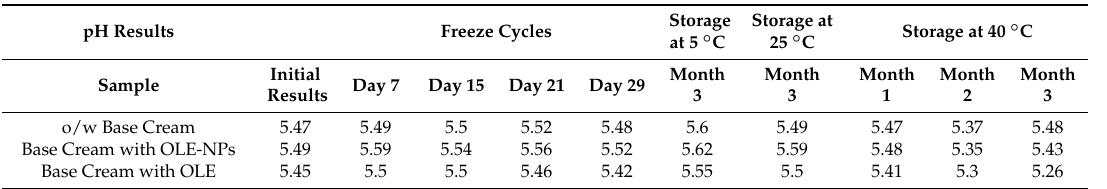
Table 4. Results of the pH measurements during the stability studies.